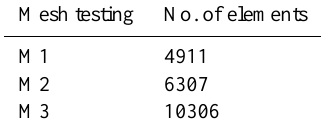
Table 1. Scenarios of mesh dependence testing. Mesh testing